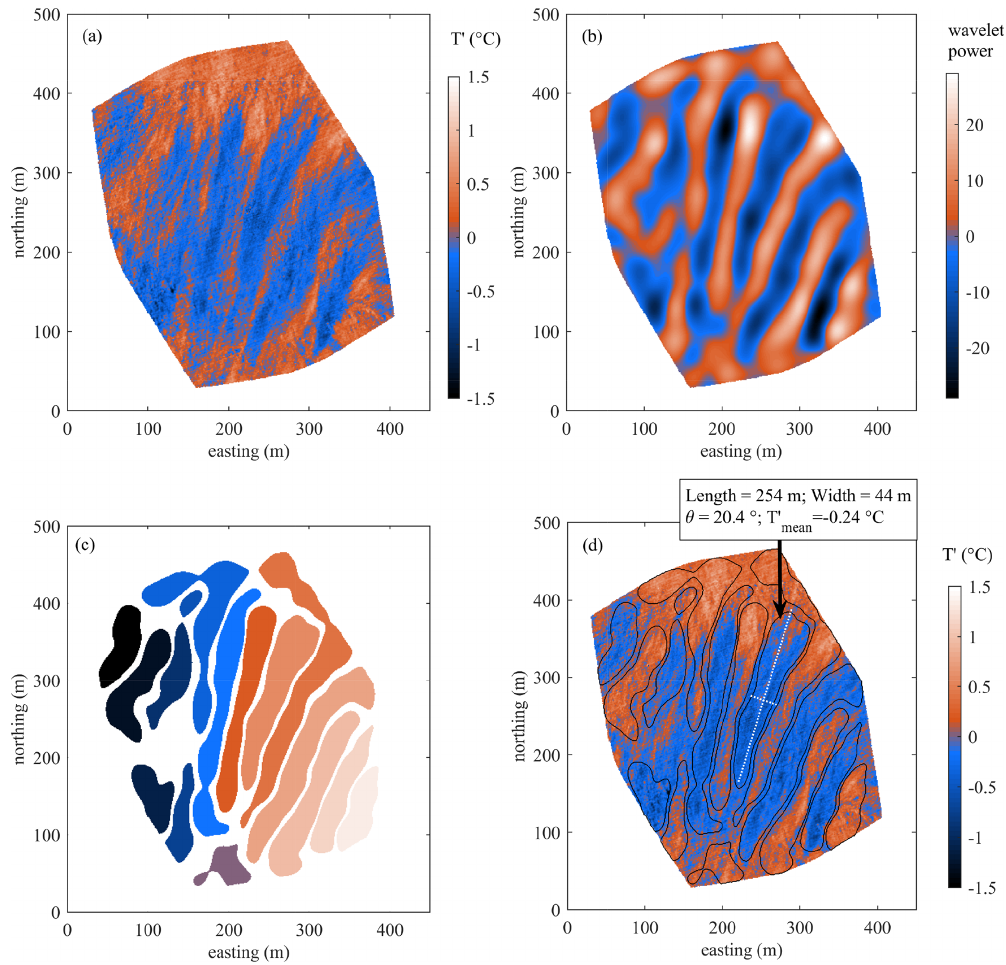
Figure 3. Large coherent structure identification method. (a) Original georeferenced T (cid:48) (x,y,t) image, (b) 2D wavelet transform at 14m scale, (c) labeled coherent structure thermal imprints obtained by watershed transform of (b) , and (d) original T (cid:48) (x,y,t) image (a) shown with the coherent structure boundaries from (c) and detailed information given for one of the identified structures (length, width, clockwise rotation from the vertical, and mean temperature excursion within its boundary). The colors in (c) are only to tell the structures apart and do not correspond to the color bars in the other